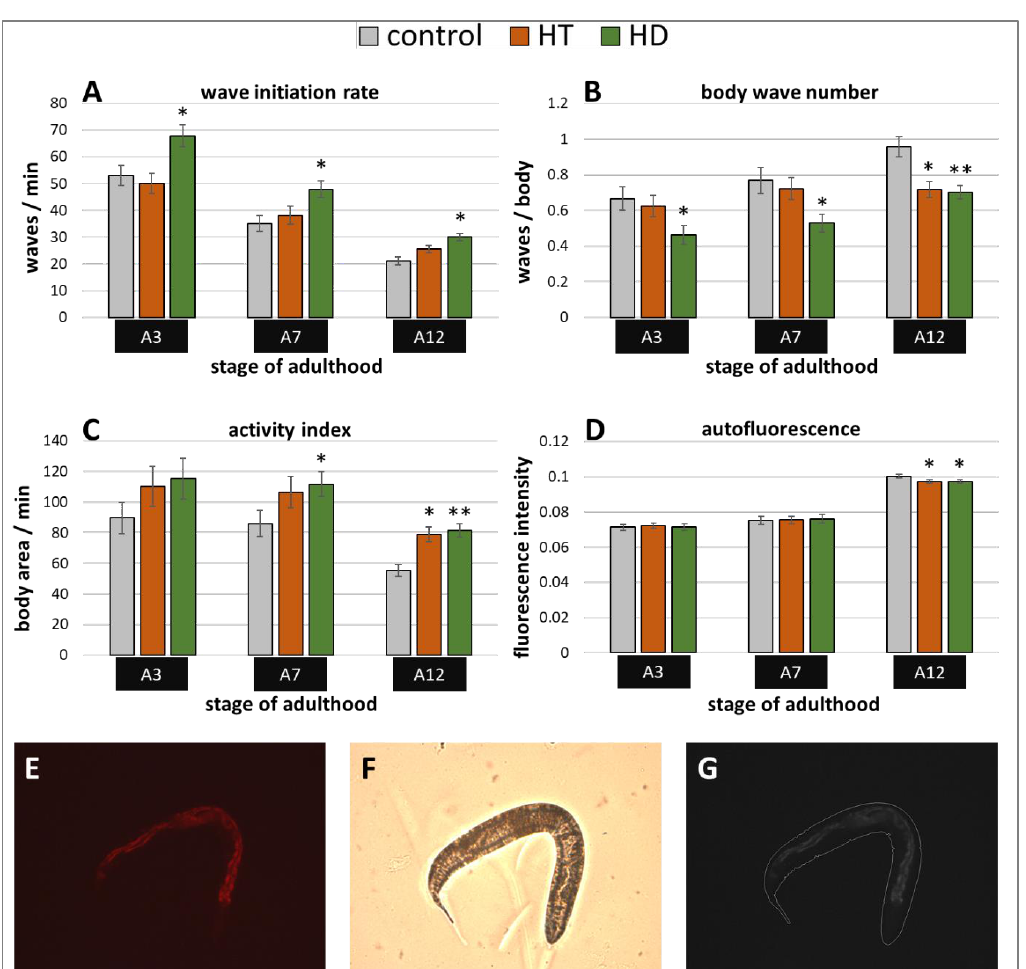
Figure 2. Healthspan benefits in wild type nematodes treated with HD and HT. The analysis of locomotion after polyphenol treatments comprises three parameters: the wave initiation rate ( A ), the body wave number ( B ) and the activity index ( C ). In two independent repeats, a total of ≥ 63 nematodes were analysed per treatment and age. In addition, the autofluorescence was monitored in two biological repeats with a total of ≥ 37 nematodes per treatment and age ( D ). Data are represented as mean ± SEM and statistical differences compared to control were considered significant at p < 0.05 (*) and p < 0.001 (**). A3, A7, A12: 3rd, 7th and 12th day of adulthood. Finally, an example for the typical appearance of red autofluorescence is shown ( E ) with the respective shot in bright field ( F ) as well as the merged and processed picture for the analysis in CellProfiler ( G